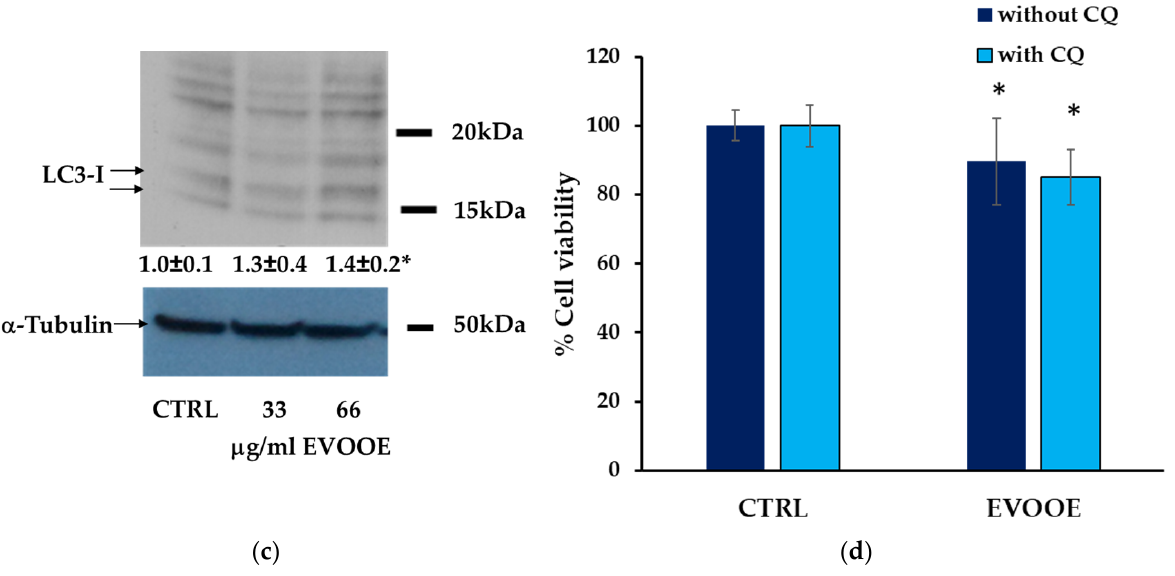
Figure 4. EVOOE induces autophagy in RT112 cells. ( a ) Representative images of cells untreated (top) and treated with EVOOE 66 μ g/mL for 24 h (bottom) following staining with CytoID. Autophagic vacuoles were visualized using fluorescent microscopy and photographed in a FITC filter with 200× magnification. ( b ) Representative histogram of CytoID flow cytometry acquisition of cells untreated (blue) and treated with EVOOE 66 μ g/mL for 24 h (green line). ( c ) Immunoblotting analysis of LC3-I/LC3-II expression in RT112 cells treated for 24 h with EVOOE. Blots are representative of one out of three separate experiments performed. Densitometric analysis (numbers between panels) is expressed as the ratio between LC3-II, and α -tubulin band intensities mean ± s.d. with symbols that indicate significance: p < 0.05 (*) compared to CTRL. ( d ) RT112 cells were treated for 24 h with the indicated concentration of 66 μ g/mL EVOOE in a single treatment or following a pre-incubation for 1 h with the autophagic inhibitor chloroquine (CQ; 20 μ M). Cell viability was evaluated by the Crystal Violet assay. Bar graphs represent the mean of three experiments (±s.d.). Symbols indicate significance: p < 0.05 (*) compared to CTRL.